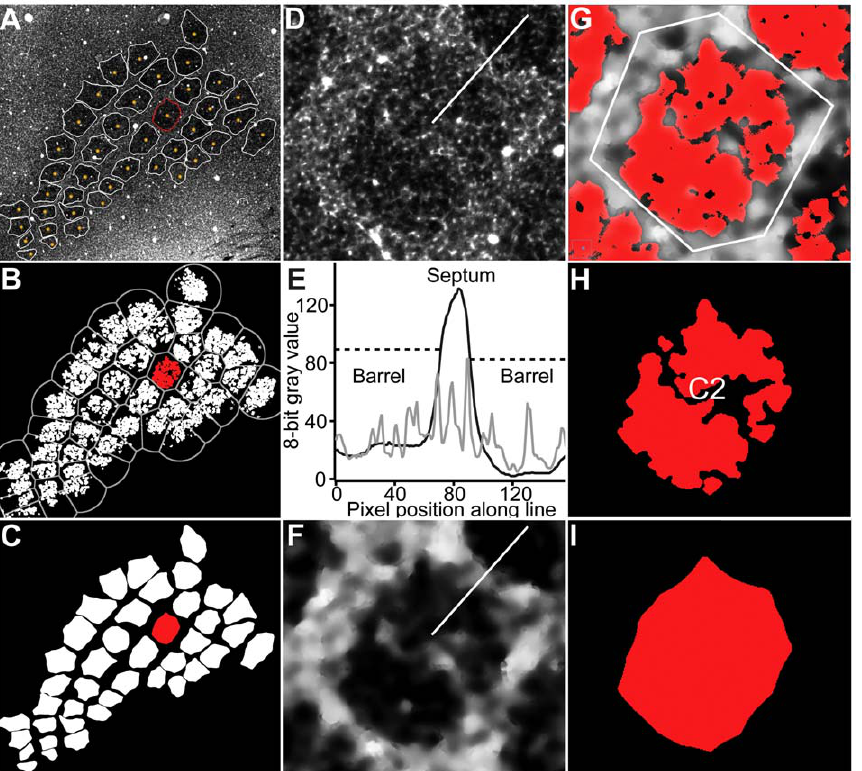
Figure 2. Reconstruction of barrel outlines from high-resolution optical section. (A) Optical section of the barrel field. Manual landmarks (yellow) are placed in barrels that are going to be segmented. White contours show the final segmentation result of this section. (B) Result of gray- value based image segmentation. Gray lines overlaid indicate the Voronoi regions (VR) of the manual landmarks used for region growing (G). (C) Final result of VR-based barrel segmentation. (D) Raw image data of barrel with red contour in A. Line shows pixels included in the line profile in E. (E) Line profiles of the intensity values along the lines before (gray; see D) and after filtering (black; see F). Dashed lines indicate threshold values used to separate different barrels from septum. (F) Result of image filtering. Line shows pixels included in the line profile in E. (G) VR-based region growing. White lines indicate border of the VR of the manual landmark. (H) VR-based barrel detection turns the binary- segmented image into an object image by assigning every segmented pixel to a barrel. (I) Closing merges all fragments belonging to one barrel.